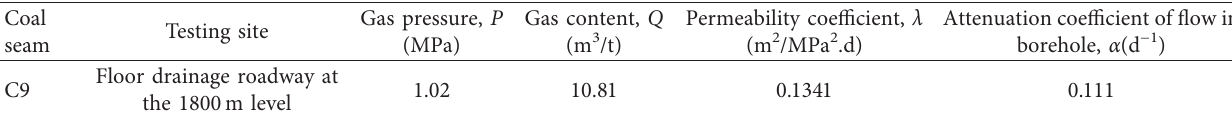
Table 4: Gas pressures in the C9 coal seam and other gas